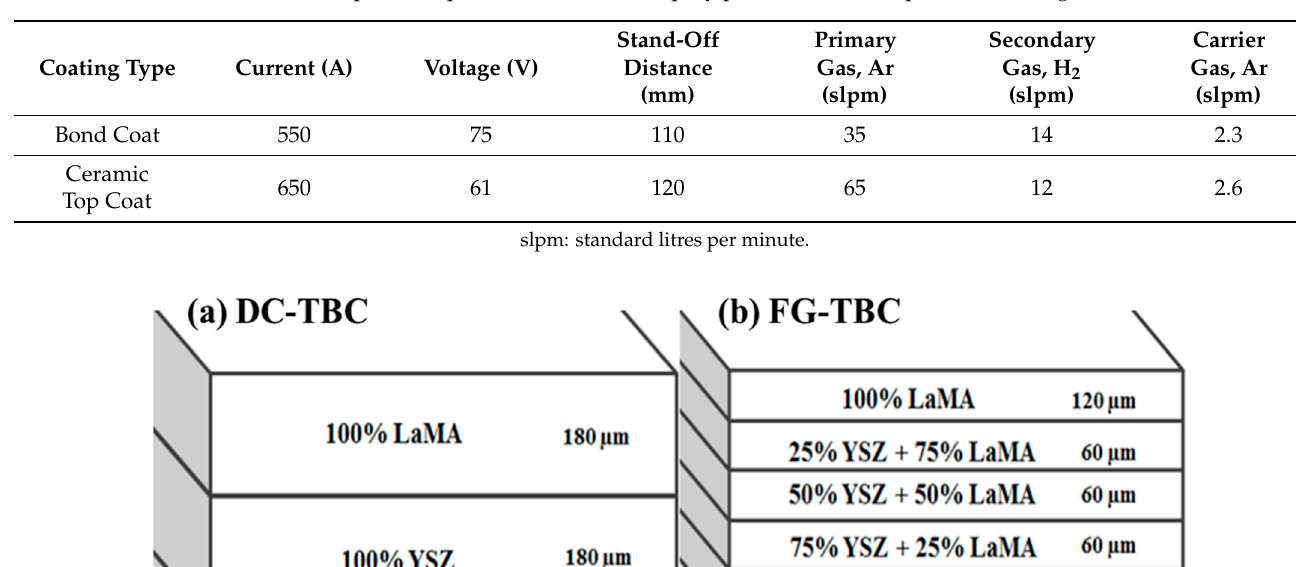
Table 1. Optimised parameters of atomic spray process used to deposit the coatings.